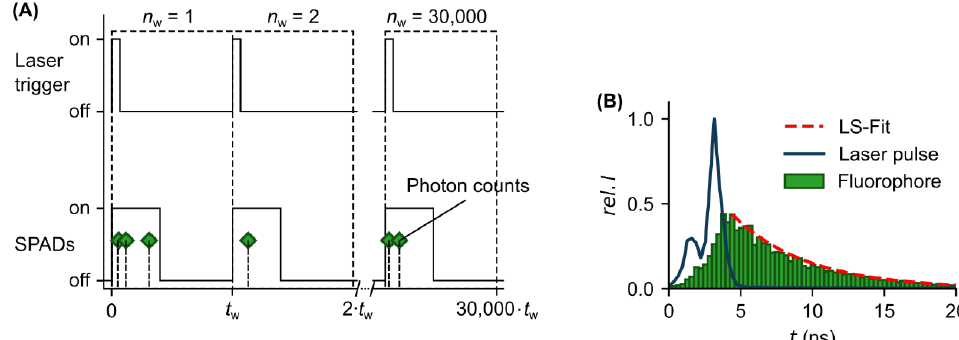
Figure 4. Experimental FL measurement. ( A ) Timing scheme of the measurement procedure. Laser trigger and SPADs were turned on and off during one measurement window. The total number of measurement windows was set to n w = 30,000. Each detected photon (green markers) during the on phase of the SPADs has a specific arrival time. ( B ) Representative measurement curves for a laser pulse ( FWHM = 1.25 ns, blue curve) and for the resulting fluorescence signal (histogram of all arrival times, green) detected by the SPAD array detector. The exponential decay of the fluorescence signal was fitted by nonlinear least square (LS) method to determine the FL (red dashed curve).